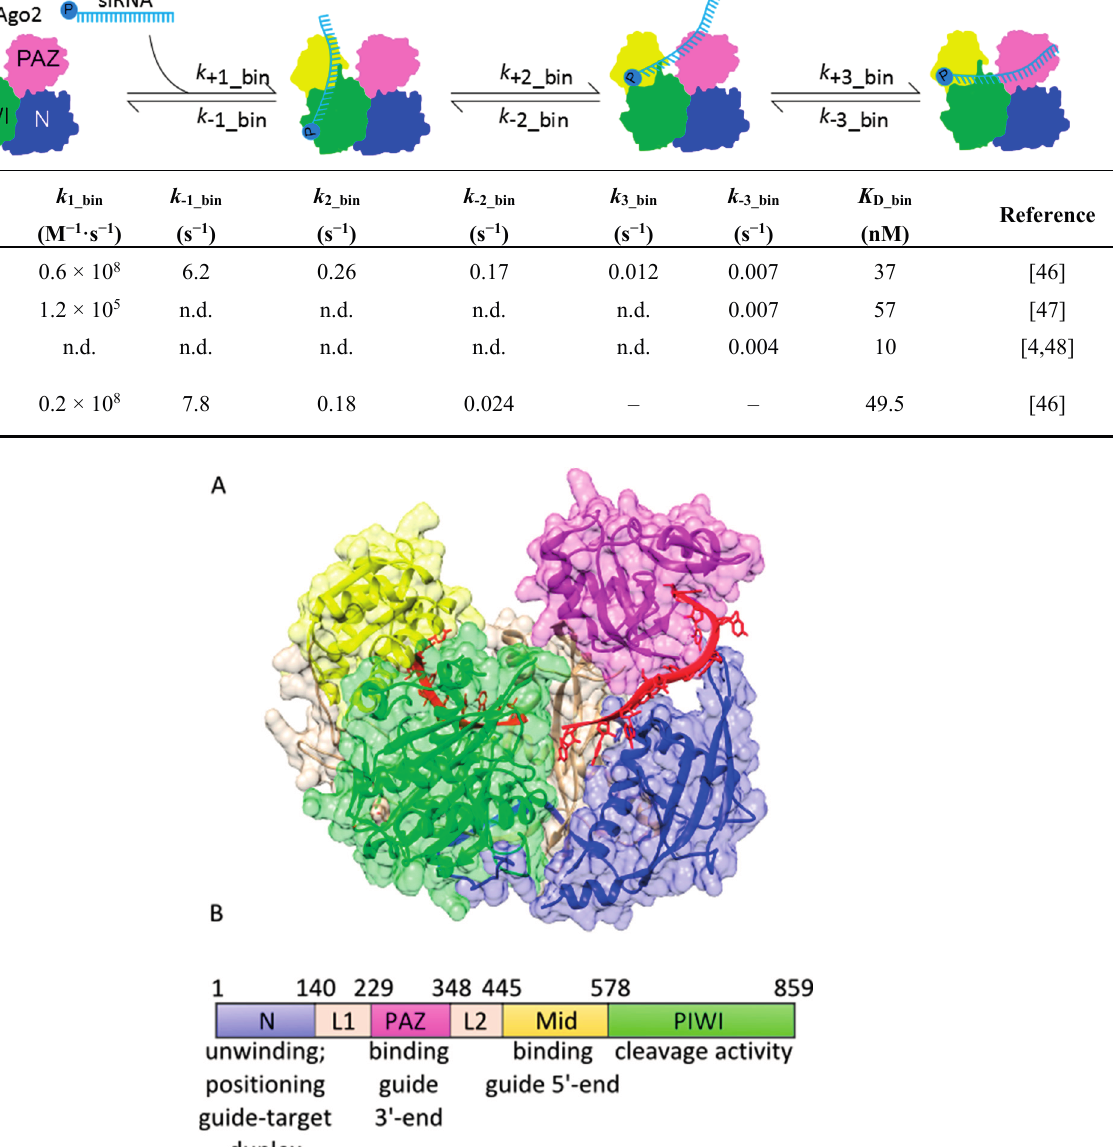
Table 1. Summary of rate constants measured for formation of binary hAgo2-guide, AaAgo-guide and hAgo2-PAZ9-guide complexes. Dissociation constants calculated from association and dissociation constants are displayed. Cartoons are based on hAgo2 X-ray structures with individual domains coloured. The guide substrate is depicted in blue with the 5 ′ -end indicated by the phosphate group. Relative positions of the guide substrate are indicated. n.d. = values not determined in this study. Collision Complex 5 ′ -End Binding 3 ′ -End Binding